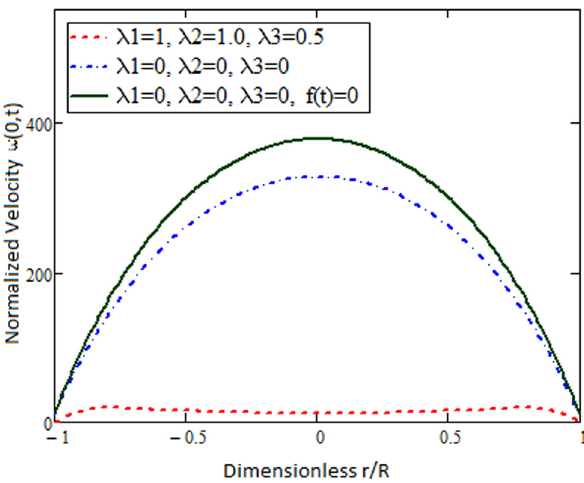
Figure 5: Comparative behavior of the Newtonian fl uid ( with ( ) = f t 0 and ( ) ≠ f t 0 ) and Burgers ’ fl uid.